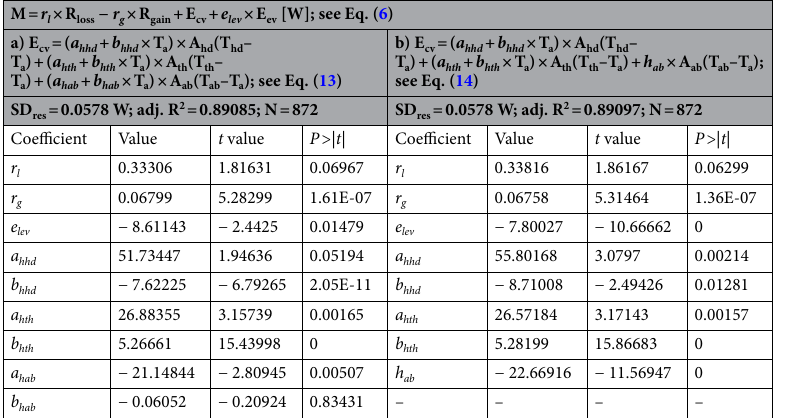
Table 2. Regression coefficients for mixed, mechanistic and correlative, heat exchange models. ( a ) Model according to Eq. (13) in Eq. (6); ANOVA: F-value = 8638.83122, df = 863, P <<< 0.0001. ( b ) Simplified model according to Eq. (14) in Eq. (6); ANOVA: F-value = 9729.44757, df = 864, P <<< 0.0001. M = metabolic energy turnover, R loss = radiative heat loss, R gain = radiative heat gain, E cv = convective heat exchange, E ev = evaporative heat exchange (~ 0.004 W; 21,22 ); A hd , A th , A ab = surface area of head, thorax and abdomen, respectively; T hd , T th , T ab = surface temperature of head, thorax and abdomen, respectively; T a = ambient air temperature; SD res = SD of residuals; adj. R 2 = adjusted for df. P >| t | provides a measure of the statistic relevance of a coefficient.